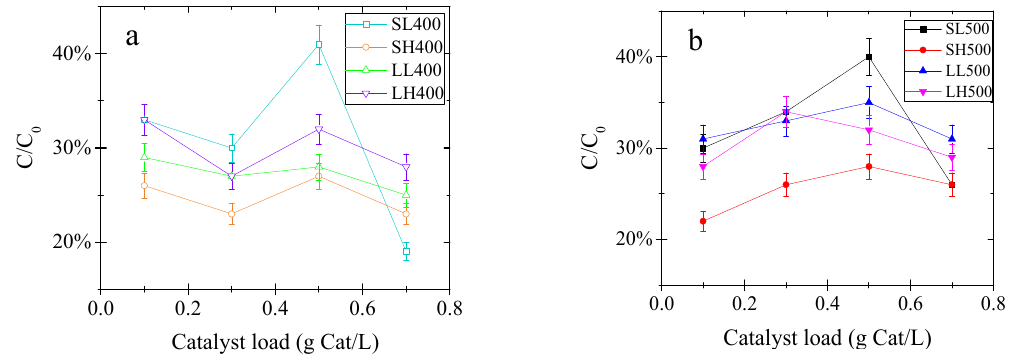
Figure 3. Evaluation of the best catalyst load to remove the cyanocomplex (hexacyanoferrate III) after 1 h of reaction ( a ) Catalysts calcined at 400 °C; ( b ) Catalysts calcined at 500 °C. Operating conditions: Initial pollutant concentration of 100 ppm, 20 min of adsorption, LED power supply of 20 W, air flow of 0.5 L/min.